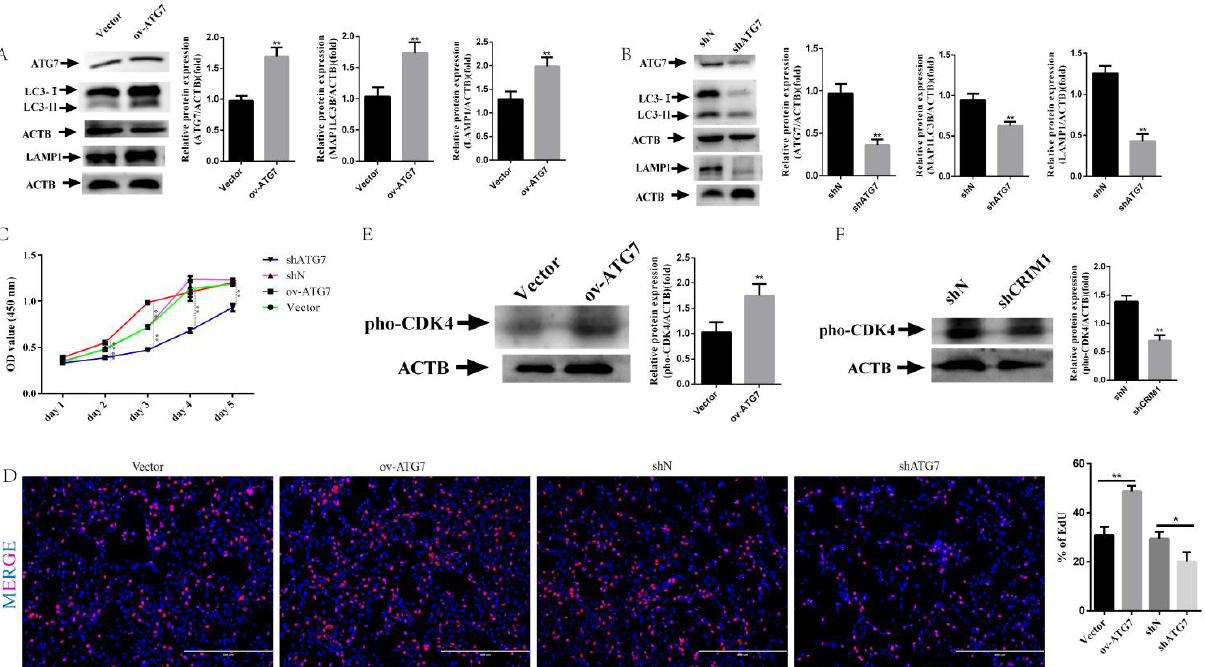
Figure 4. Effect of ATG7 on cell proliferation in shCRIM1 EECs. ( A , B ) The shCRIM1 EECs were infected with an empty vector lentivirus (Vector), ATG7 overexpression (ov-ATG7), shN or shATG7 lentivirus for 48 h under P 4 , E 2 and IFN- τ treatment. Total proteins from the Vector, ov-ATG7, shN and shATG7 groups were subjected to Western blotting. ( C ) Growth curves of the Vector, ov-ATG7, shN and shATG7 groups were determined by the CCK-8 method. The solid line represents the significance between Vector and ov-ATG7 groups; the dotted line represents the significance between shN and shATG7 groups. ( D ) The Vector, ov-ATG7, shN and shATG7 groups were collected to measure DNA synthesis by EdU defect DNA synthesis by EdU proliferation assay. ( E ) Western blot analysis of pho-CDK4 expression in the Vector, ov-ATG7, shN and shATG7 groups. The data are presented as the means ± SEM of three independent experiments. * Significant difference ( p < 0.05) compared with other groups; ** Significant difference ( p < 0.01) compared with other groups.